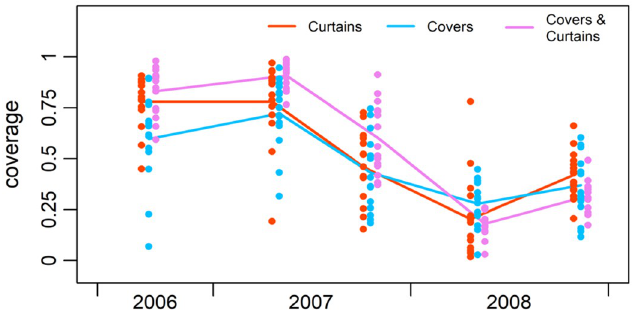
Fig 5. Coverage of the interventions by study arm over time. Individual dots represent individual